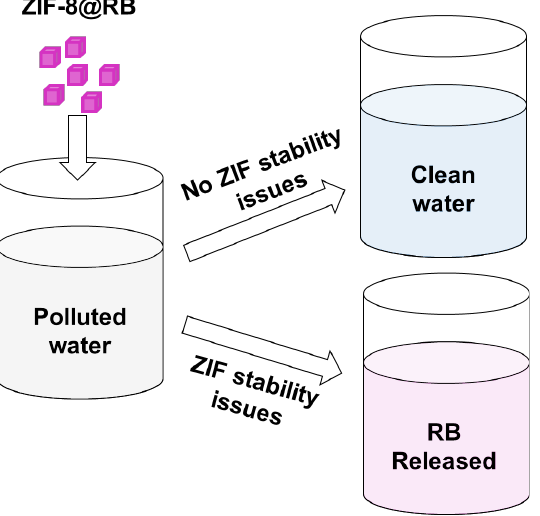
Figure 1. Scheme illustrating the self-reporting mechanism of ZIF-8@RB when stability issues are experienced during a pollutant removal application. RB, rhodamine B.